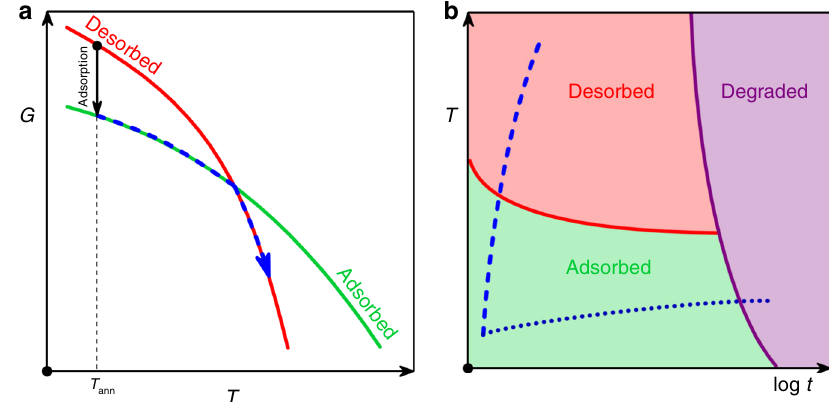
Fig. 1 Phase diagram and kinetic stability of an adsorbed layer. a Schematic representation of the dependence of Gibbs-free energy ( G ) on temperature ( T ) for the desorbed (red line) and the adsorbed (green line) phases. In our experiments, adsorption is achieved isothermally at low temperatures; the adsorbed layers are then heated at a constant rate up to high temperatures where desorption takes place spontaneously. The blue dashed line indicates the thermodynamic path followed by heating the sample at a high rate. b Schematic representation of TTT (time – temperature – transformation) diagram for an adsorbed polymer layer. The blue dashed line and the dark blue dotted line indicate CHT (constant heat transformation) processing protocols at, respectively, fast and slow rate. Degradation is circumvented by heating the adsorbed layer at a fast scanning